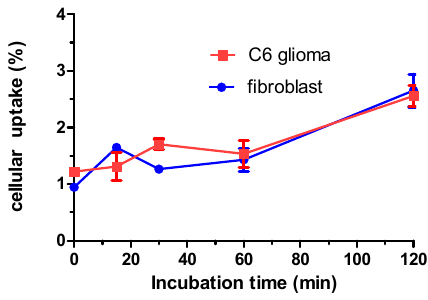
Figure 3. Comparison of internalization rate of [ 18 F]FOFA {[ 18 F] -1 } between C6-glioma brain tumour and the control fibroblast cells. Increasing uptake rate is remarkable in the lateral stage. Data are from one experiment with triplicate samples and are expressed as mean ± SD.